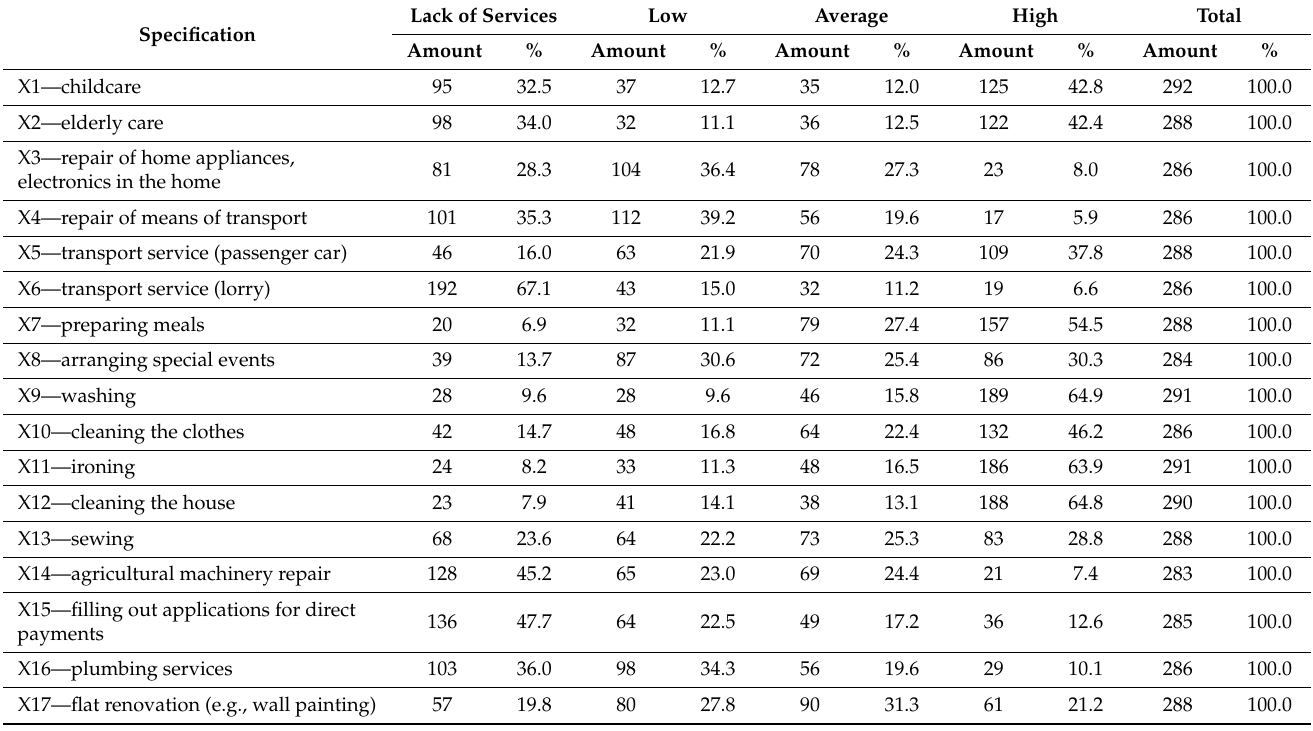
Table 2. Declared level of services performed independently as part of managing a